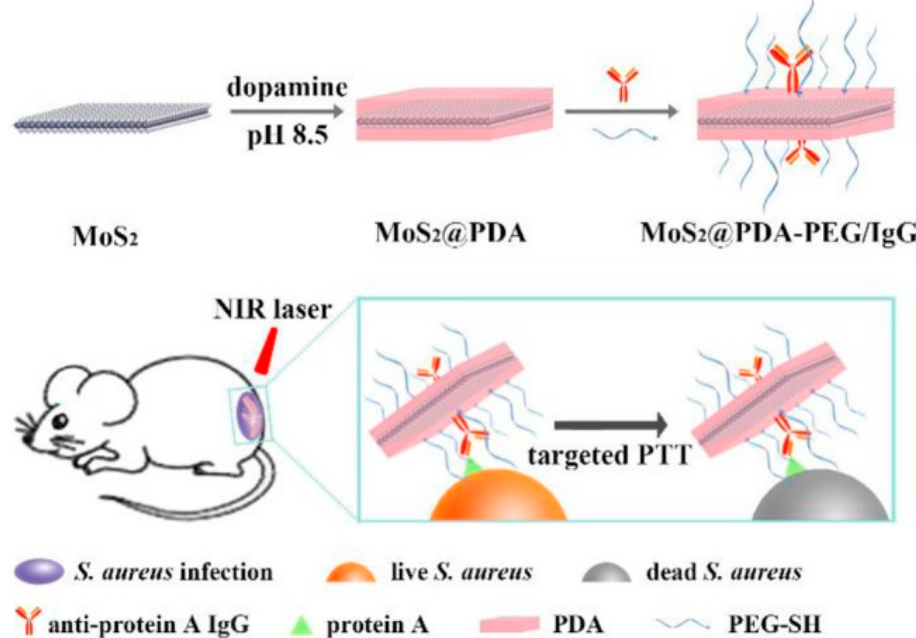
Figure 3. Preparation of MoS 2 @PDA-PEG / IgG nanosheets (NSs) (MPPI NSs) and their application for the targeted photothermal therapy (PTT) of S. aureus focal infection. Reproduced from [42], with permission from Frontiers Media S.A., 2019.